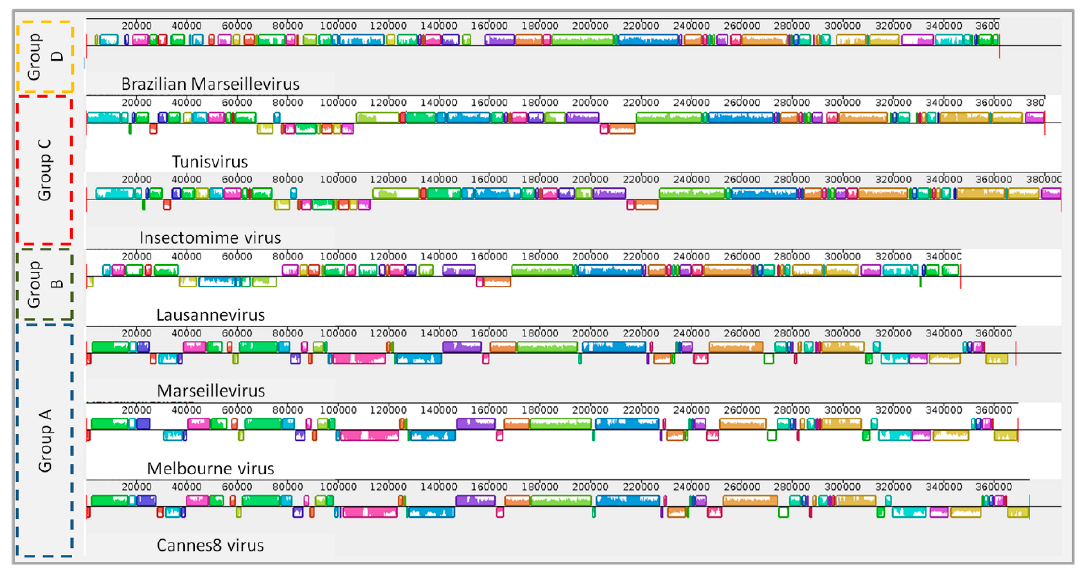
Figure 1. Genome alignment of BrMV and other marseillevirus strains. The figure shows genome architecture and synteny. Schematic genome alignment diagram was obtained using the MAUVE software package [37].